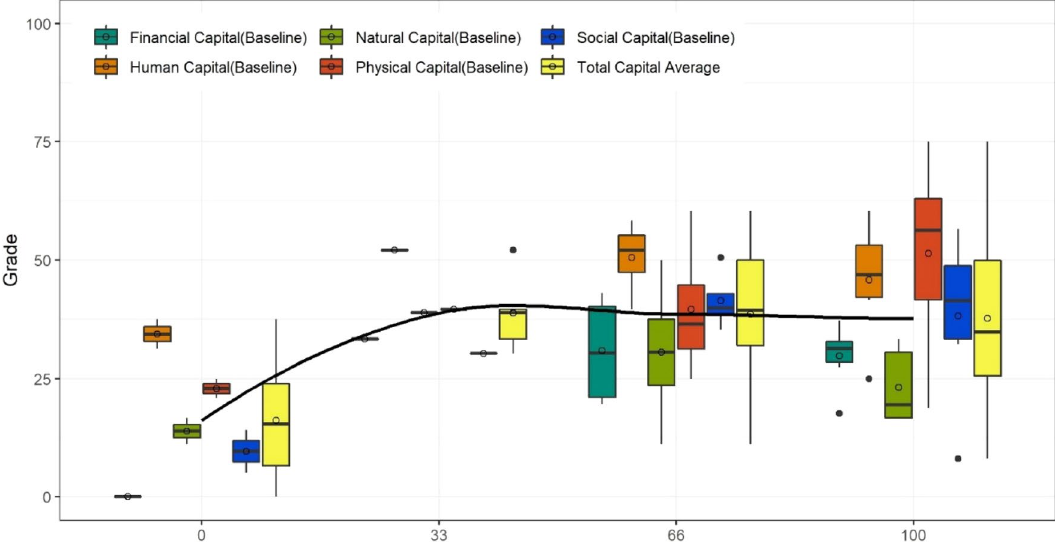
Figure 3. Relating the average capital grades with Death and Injury due to flood